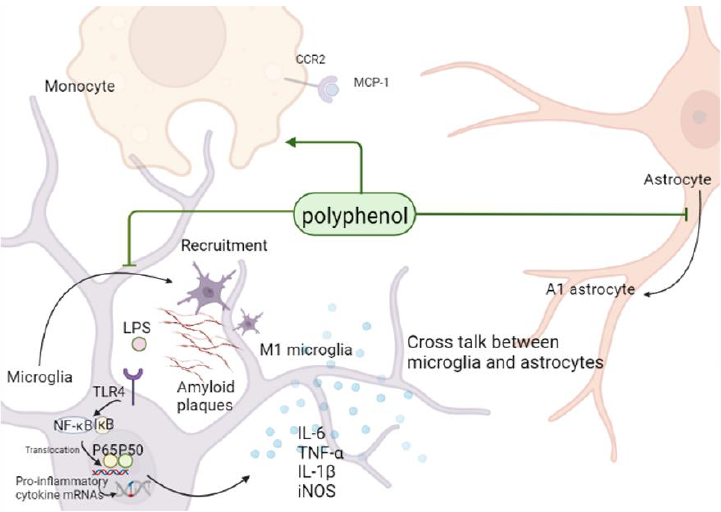
Figure 3. Regulatory roles of polyphenols in the context of neuroinflammation: polyphenols inhibit the activation of astrocytes and transformation of microglia to pro-inflammatory phenotypes in the brain by inhibiting NF- κB pathway, reduce the secretion of inflammatory factors, improve the inflammatory environment in the brain and affect the phagocytosis of monocytes/ macrophages, to eventually alleviate AD symptoms. LPS, lipopolysaccharide; NF- κB, tumor necrosis factor - α; TLR4, Toll-like receptor 4; IL-6, interleukin-6; IL- 1β, interleukin - 1β; TNF - α, tumor necrosis factor- α; iNOS, inducible nitric oxide synthase.